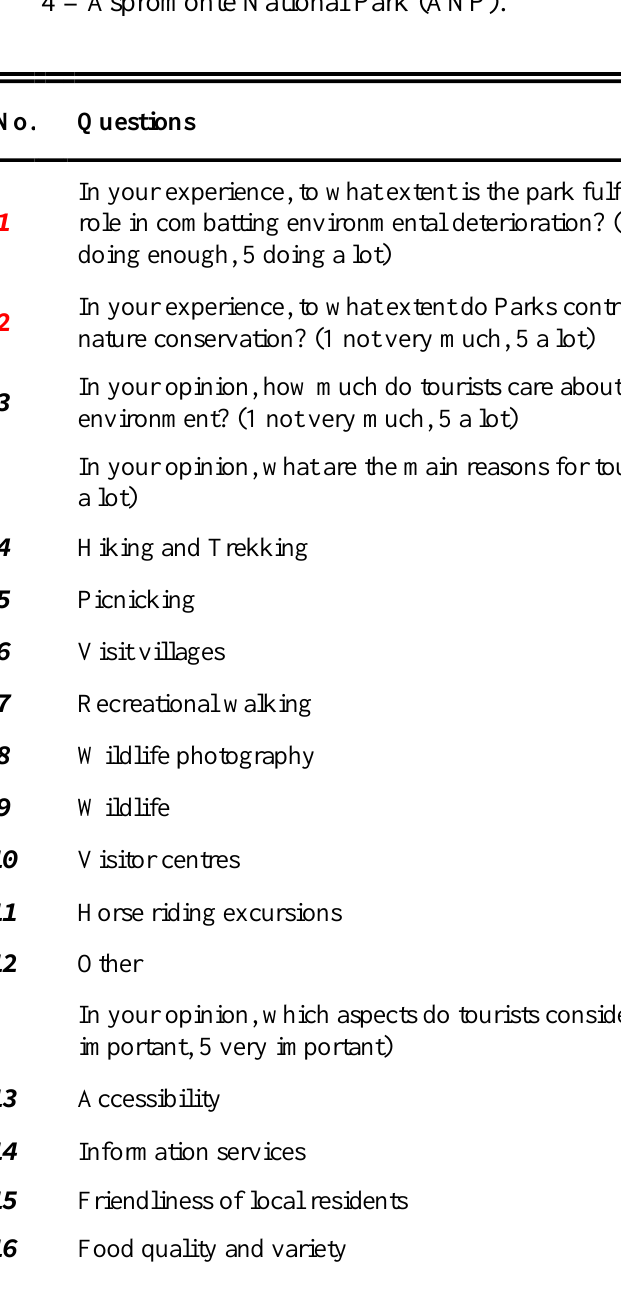
Table A2 Quantitative question scores. Mean values for all four National Parks (Mean) and relative standard deviation (SD) together with mean values for each National Park are reported. For each question, PC1 loading values are also shown. PCA loading values in bold highlight the positive correlated values from bootstrapping. Numbers (No.) in red highlight questions aimed to receive the hiking guides’ own opinion, whereas numbers in black identify questions aimed to know the feedback that hiking guides get from tourists. 1 = Foreste Casentinesi, Monte Falterona and Campigna